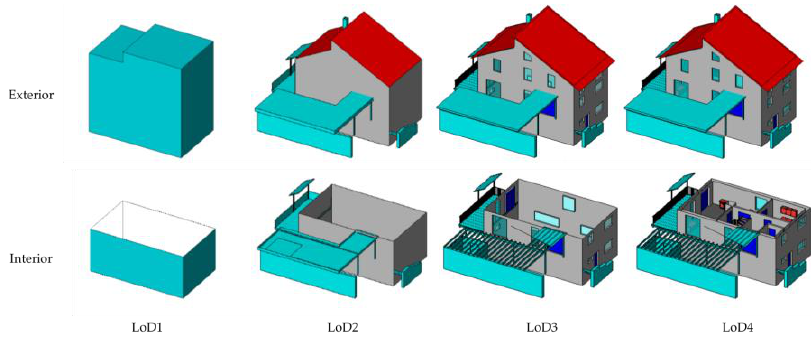
Figure 3. Building models in LoD1-LoD4 (source: